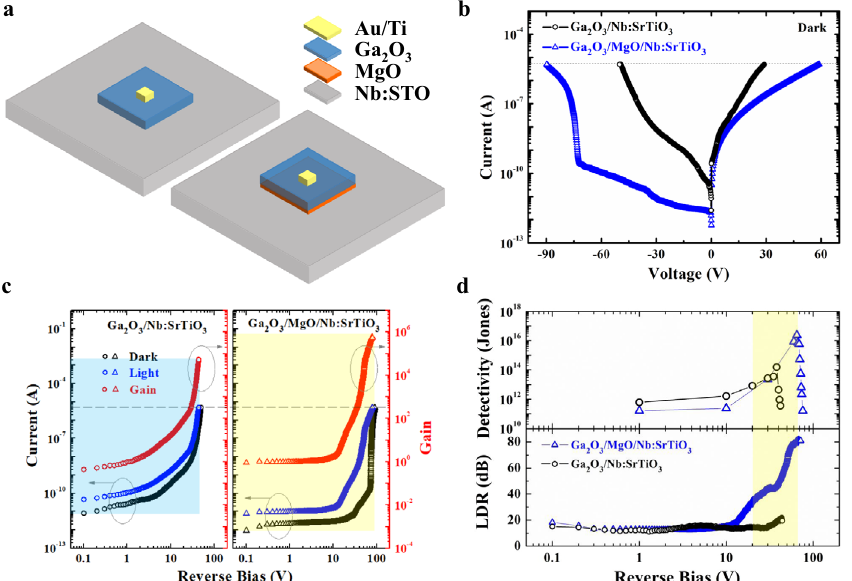
Fig. 3 | APDs performance comparison of the nBn unipolar barrier hetero- structureandthen – nisotypeheterostructure.a Schematicdeviceillustrationof the Ga 2 O 3 /MgO/Nb:STO nBn unipolar barrier APD, and the Ga 2 O 3 /Nb:STO n – n